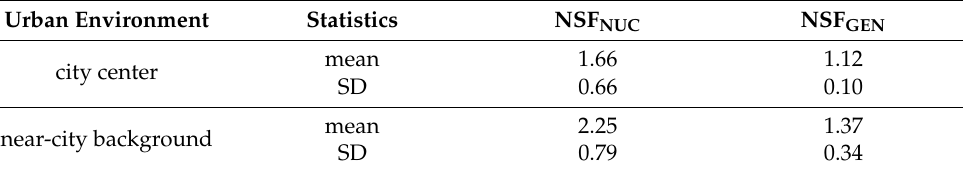
Figure 3. Relative occurrence frequency of new aerosol particle formation in the city center over 8 measurement years separately for days of the week and for workdays and holidays. The solid horizontal line indicates the overall mean, and the yellow band shows its standard deviation. The actual counts of the new particle formation event days are written above the columns. Table 3. Nucleation strength factor values for nucleation days (NSF NUC ) and for all days (NSF GEN ) separately for the city center and near-city background sites during the whole measurement time